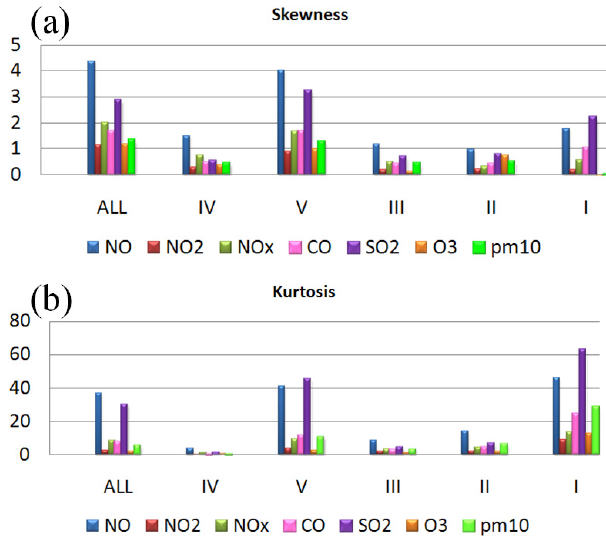
Fig. 11. For of the gases (NO, NO 2 , NO x , CO, SO 2 , and O 3 ) and aerosol (PM 10 ) , the skewness (panel a ) and kurtosis (panel b ) of the original time series (ALL) and the reconstructed time series for the frequency bands of IV, V, III, II, and